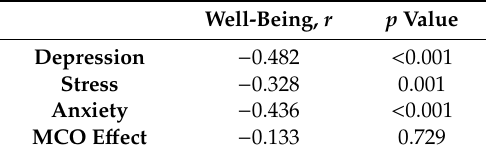
Table 3. Correlations between mental wellbeing and depression, anxiety, stress, and MCO e ff ect. Well-Being, r